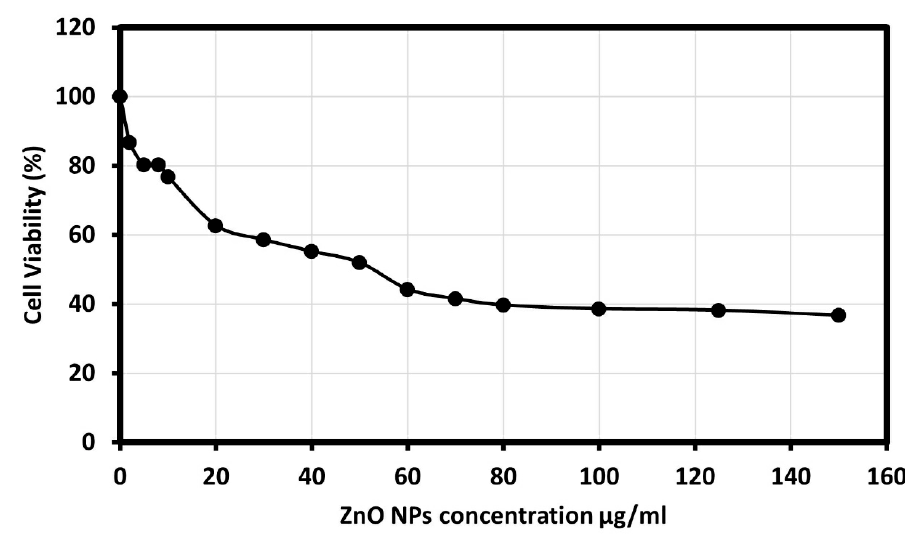
Figure 5. Growth of bacteria ( E. coli ) exposed to various concentrations of ZnO NPs (20–600 μ g/mL).